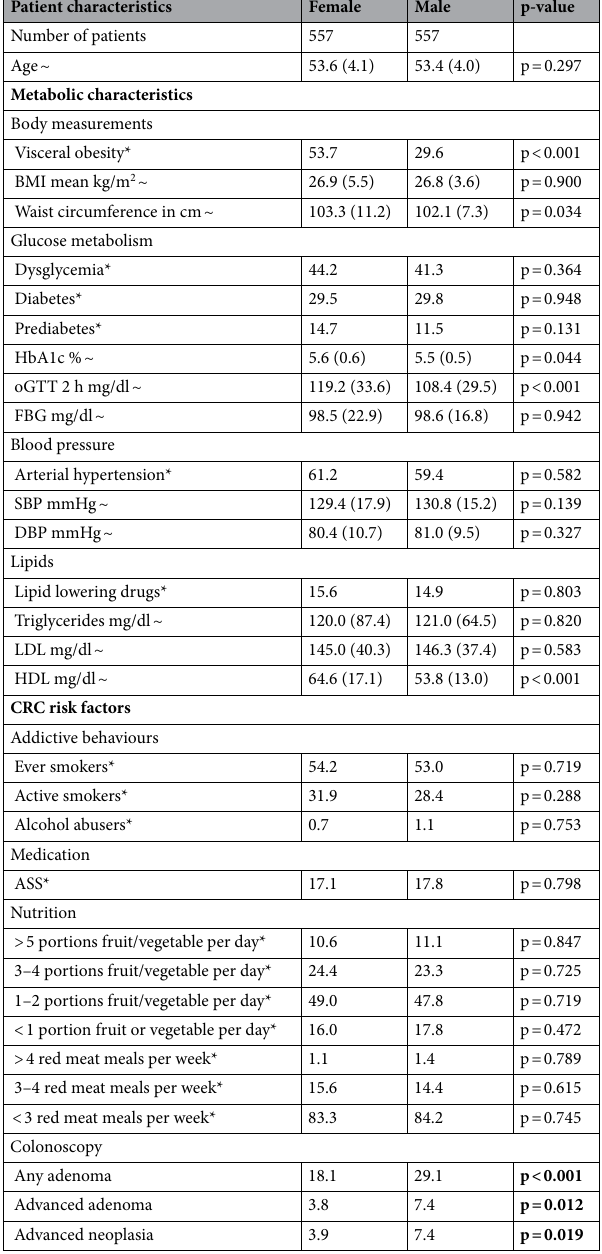
Table 4. Propensity matched analysis of female and male patients. BMI body mass index; oGTT oral glucose tolerance test; FBG fasting blood glucose; SBP systolic blood pressure; DBP diastolic blood pressure; LDL